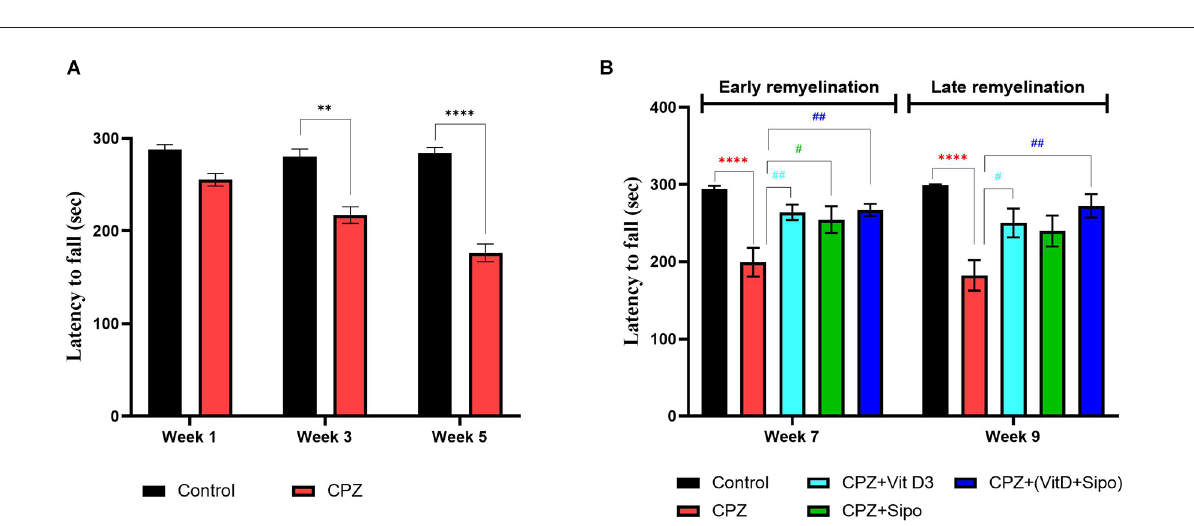
FIGURE5 Rotarod test. (A) Effects of CPZ on the motor coordination and balance in the rotarod test during the demyelination stage. (B) Effects of different treatments on the motor coordination and balance in the rotarod test during early and late remyelination stages. Data are represented as the mean ± SEM, and two-way ANOVA was used followed by Šídák’s and Tukey’s multiple comparisons tests (A,B) were used, respectively. CPZ, cuprizone; Vit D3, vitamin D3; Sipo, siponimod. ( ∗ ) Indicates a significant difference vs. the control group; ( # ) indicates a significant difference vs. CPZ group. ∗∗ p < 0.01, ∗∗∗∗ p < 0.0001, # p < 0.05, and ## p <